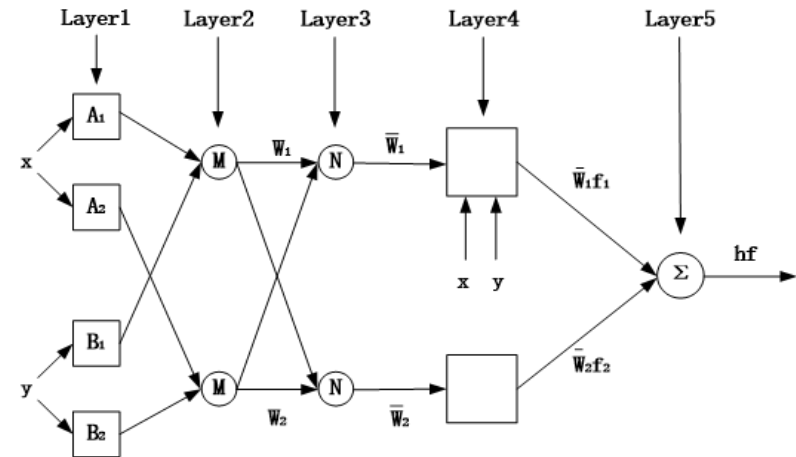
Figure 3. First-order adaptive fuzzy neural network inference system. Table 1. Membership function parameters of Nusselt modeling.